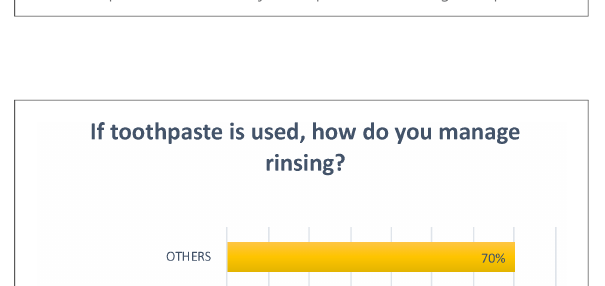
FIGURE 3 At what age do you think oral hygiene routines should be started? 55% replied before the milk teeth come through; 45% replied after the milk teeth come